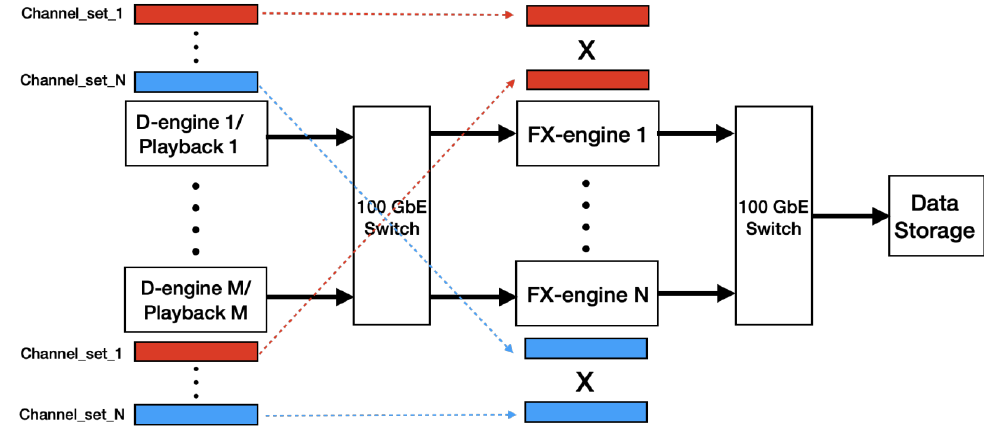
Figure 6. Full compact architecture of the proposed